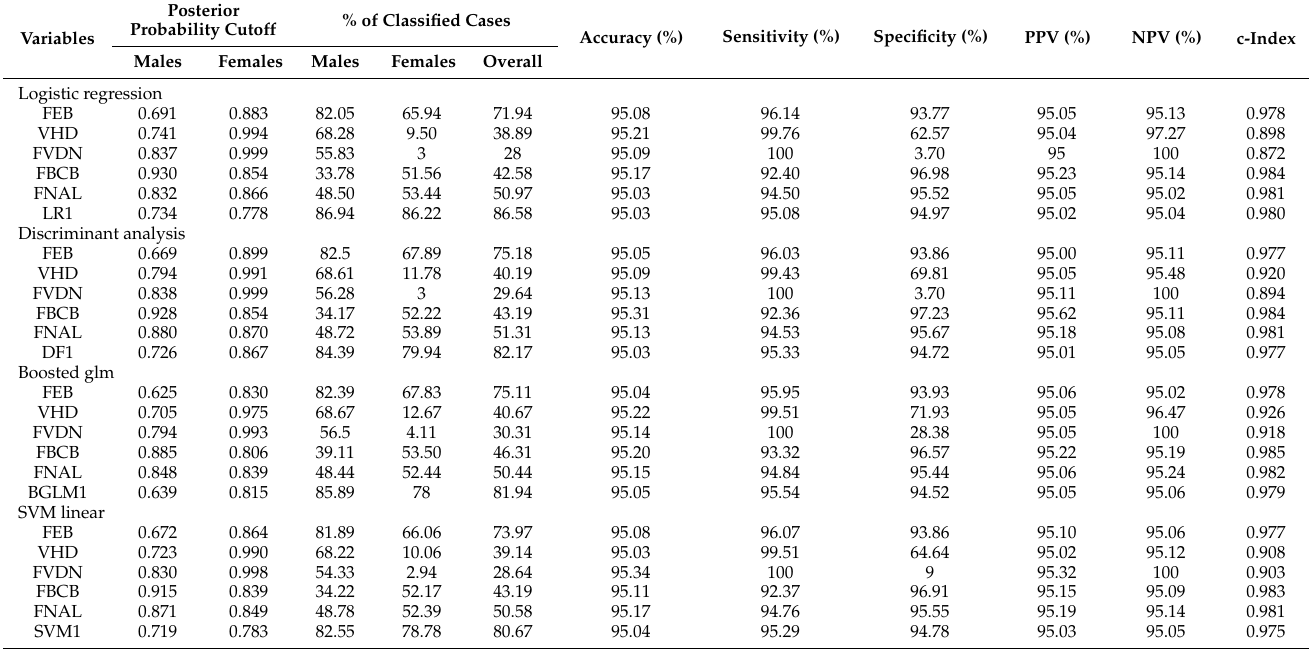
Table 3. LGOCV classification results with ABC adjustment in the training